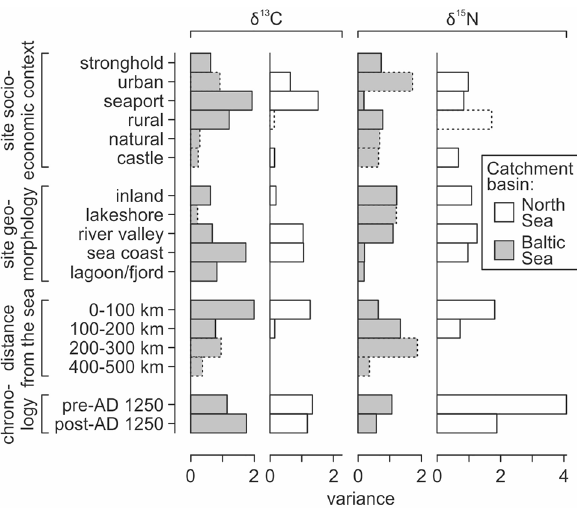
Figure 6. Variance (square of standard deviation) of δ 13 C and δ 15 N values in medieval and post-medieval cats grouped by site socio-economic context, site geomorphology, distance from the sea, and chronology. Dashed contour line used for groups with low number of specimens (n < 10). Groups with n < 3 (only North Sea region: monastery and 200–300 km distance from the sea) are not included. For detailed values see SI Appendix Tables S1,